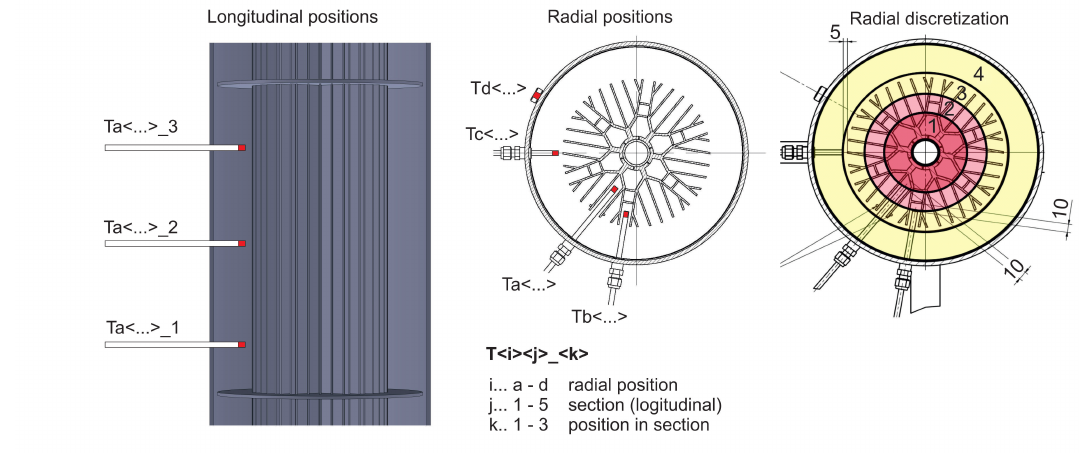
Figure 3. Testing point positions in the